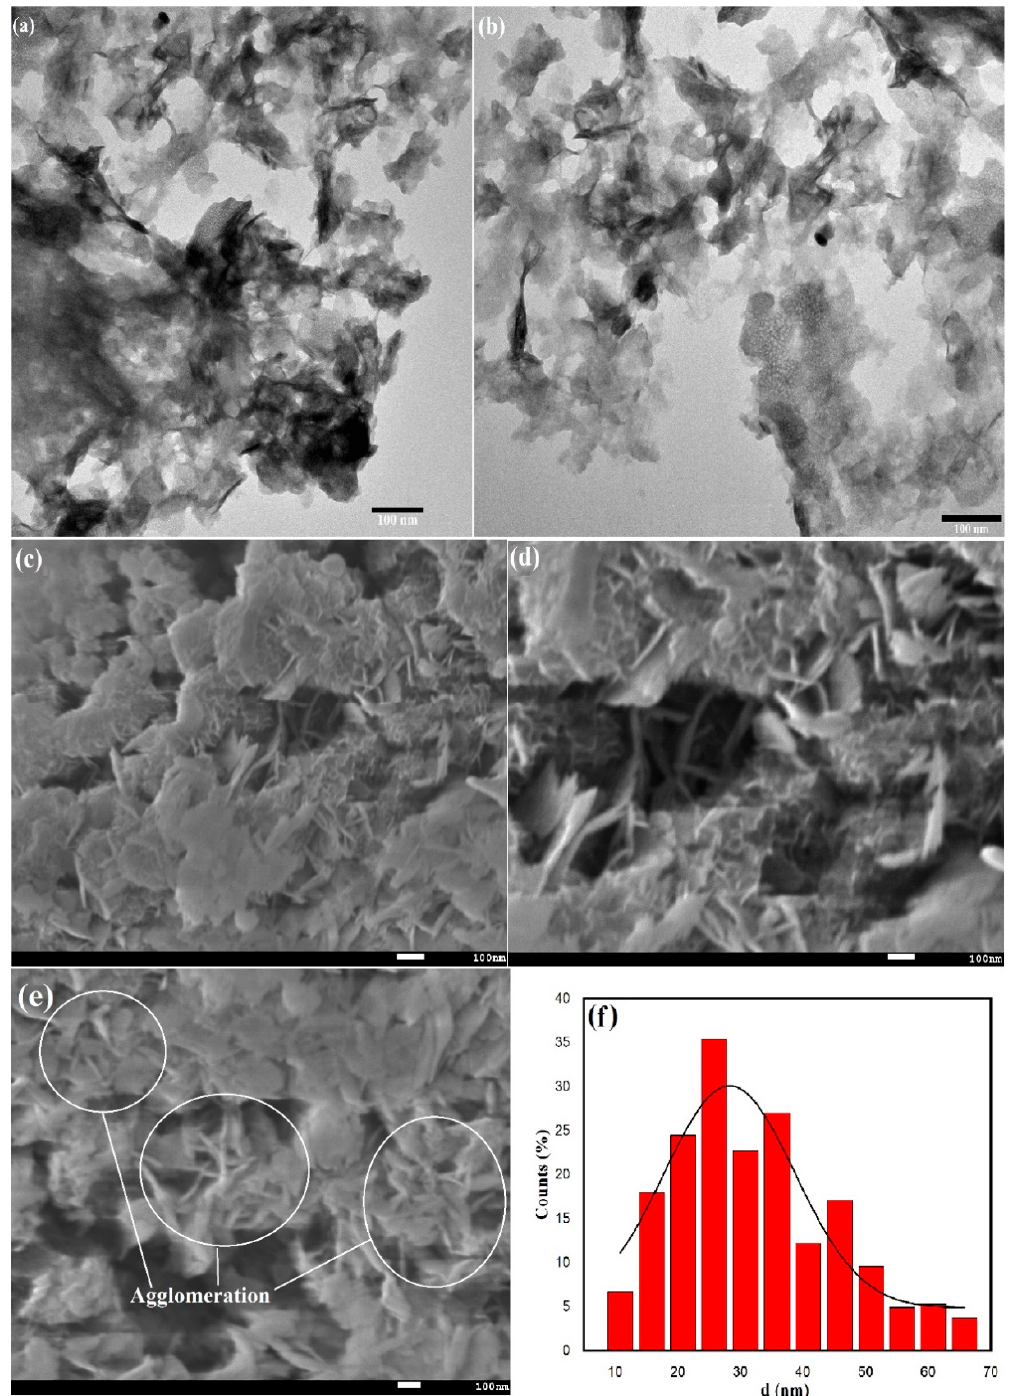
Figure 5. Transmission electron microscopy (TEM) ( a , b ), scanning electron microscopy (SEM) ( c – e ) micrographs of biosynthesized Cu-Co-Ni trimetallic nanoparticles, and ( f ) particle size distribution histogram of Cu-Co-Ni trimetallic nanoparticles.